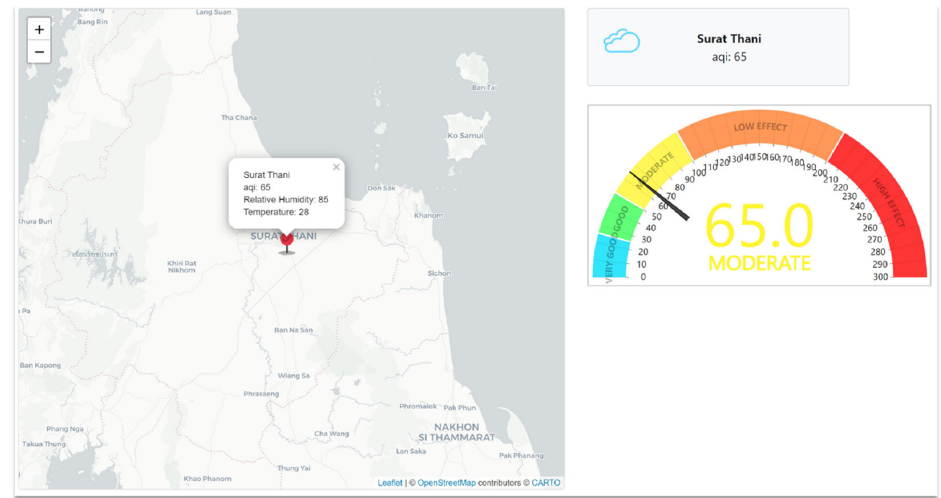
Figure 12. Augmented map reports on Air Quality Index (AQI).